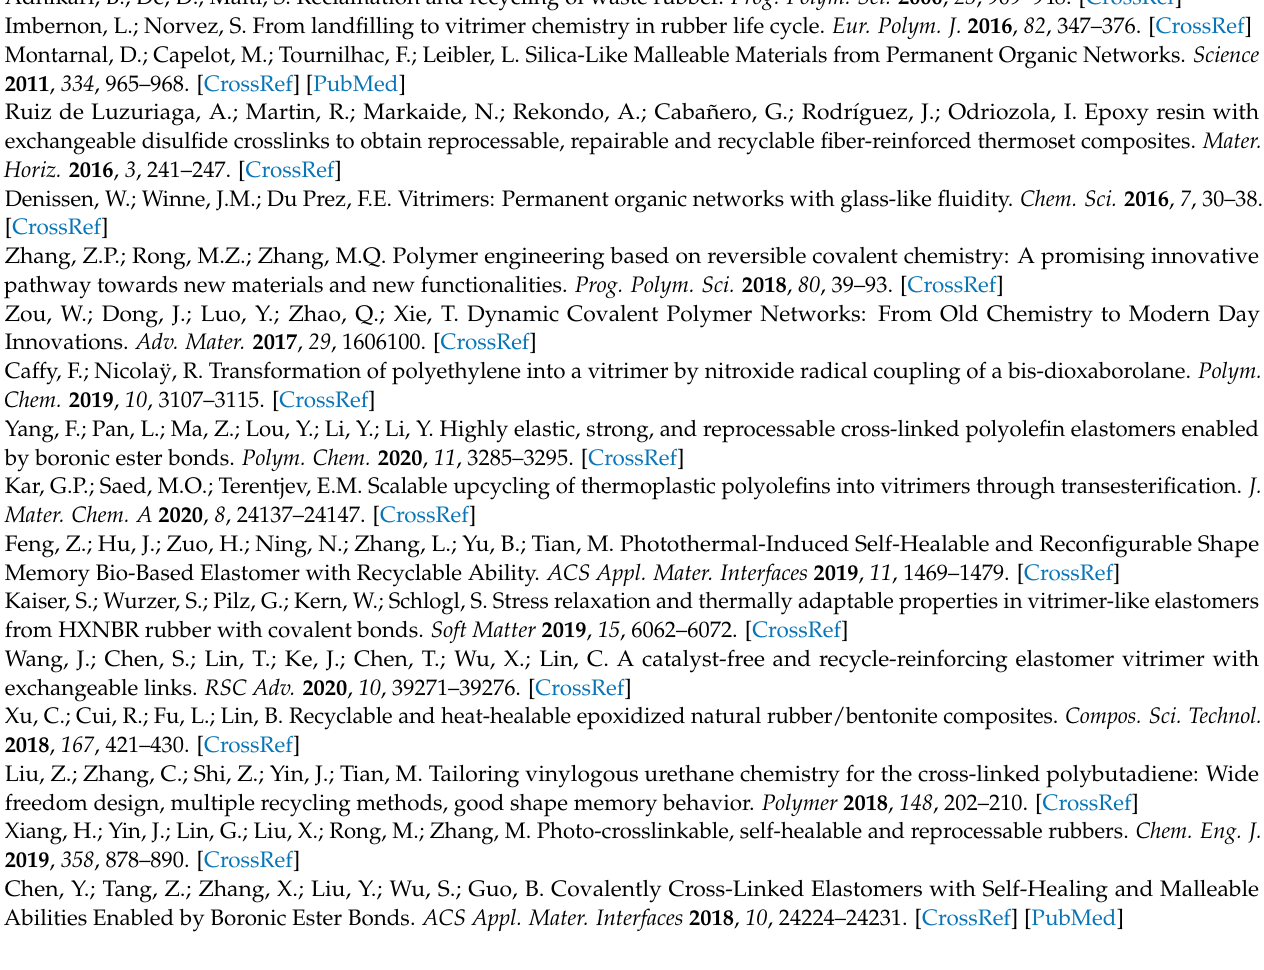
150 ◦ C for 2 h; Figure S7. The relationship between mechanical properties and crosslinking density; Figure S8. Typical stress–strain curves of vitrimer 4 and EPB25-DA; Figure S9. Stress relaxation curves of vitrimers; Figure S10. Creep recovery curves of PB vitrimers; Figure S11. The relationship between permanent deformation and relaxation times at 150 ◦ C; Figure S12. Typical stress–strain curves of PB vitrimers; Figure S13. (a) TGA of original and recycled vitrimer 4; (b) FT-IR spectra of original and recycled vitrimer 4; Figure S14. Typical stress–strain curves of original and recycled EPB25-DA; Table S1. The mechanical properties of PB